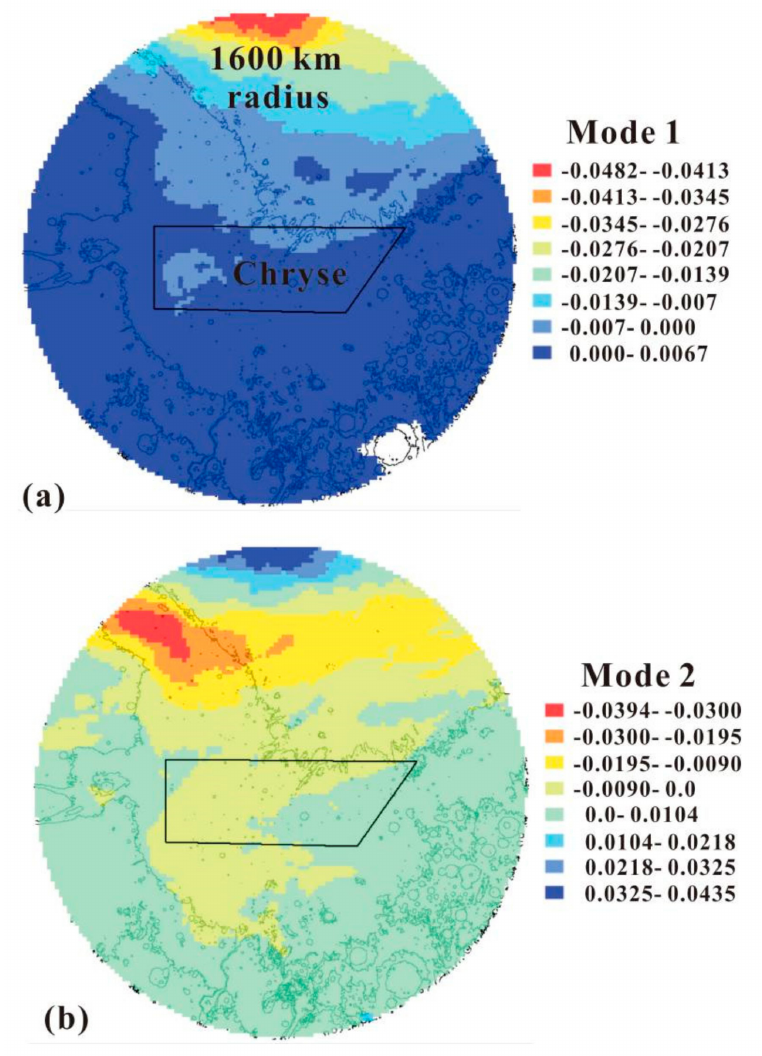
Figure 11. Eigenvector image patterns for Mode 1 ( a ) and Mode 2 ( b ) of temporal variance within Chryse’s 1600 km-radius ring in 0.5 ◦ grids. The black polygon shows the Chryse landing area. The topographic map is shown in black contours (2 km apart) for